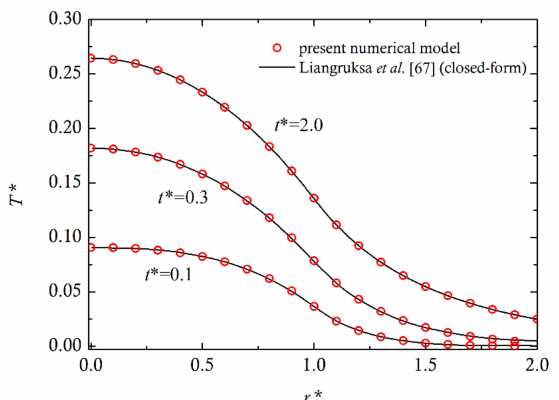
Figure 4. Comparison of the present computational results for various dimensionless treatment times with the closed-form solution by Liangruksa et al. [67]. T * is the dimensionless temperature, r * the dimensionless distance from the tumor center and t * is the dimensionless time, as defined in Liangruksa et al.